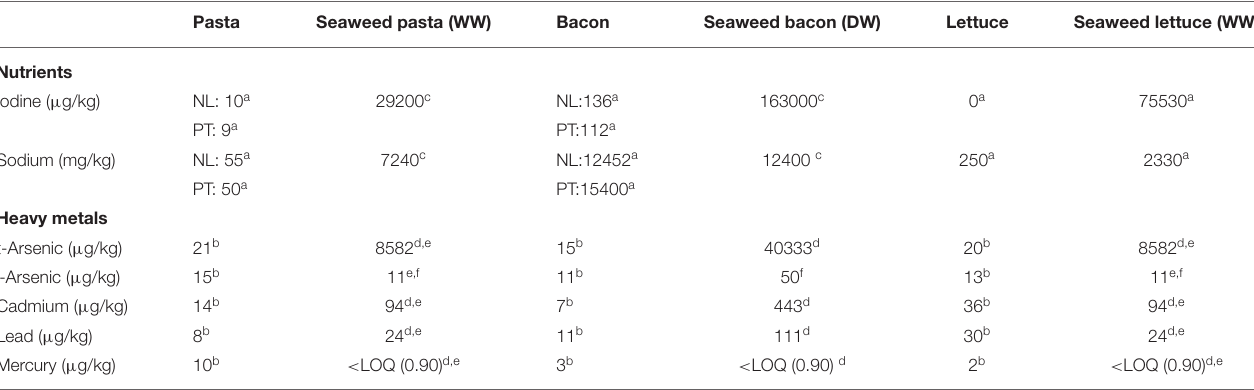
TABLE 2 | Concentrations of iodine, sodium, arsenic, cadmium, lead, and mercury in unit per kg of pasta, bacon, lettuce, and novel seaweed foods. Pasta Seaweed pasta